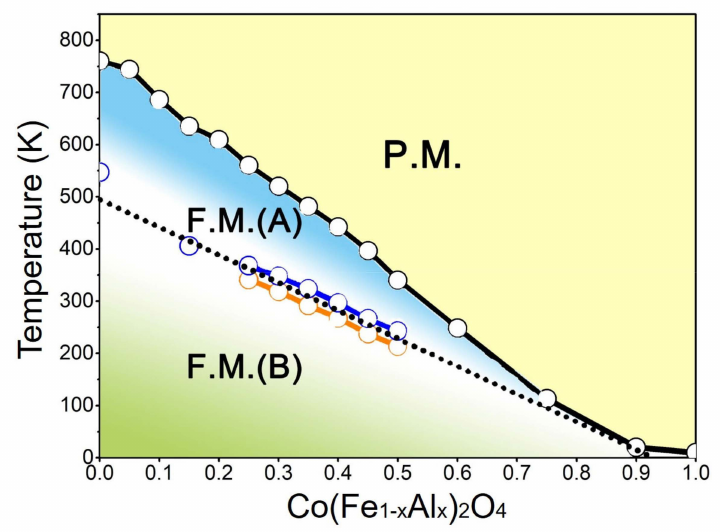
Figure 4. (Color online). The temperature–composition phase diagram of Co(Fe 1 − x Al x ) 2 O 4 . P.M. denotes paramagnetic phase; F.M. (A) and F.M. (B) denote the ferrimagnetic A phase and ferrimagnetic B phase, respectively. Red circles and blue circles refer to the anomalies appearing on the magnetic susceptibility versus temperature curves in Figure